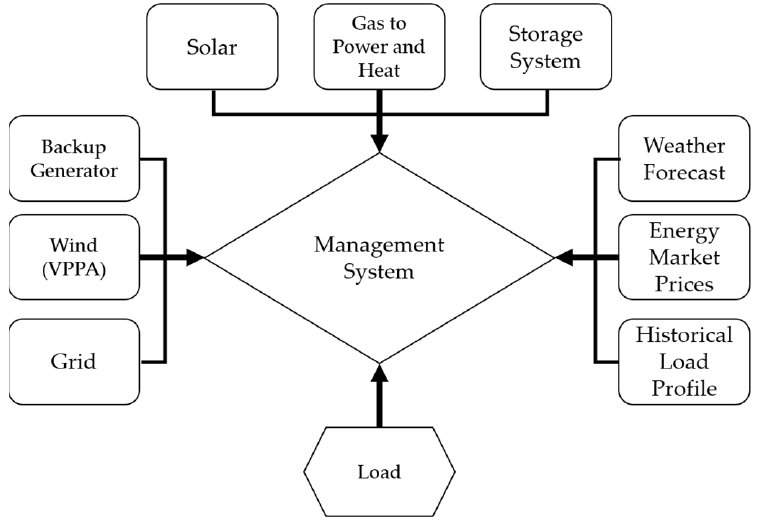
Figure 2. Energy management system example.